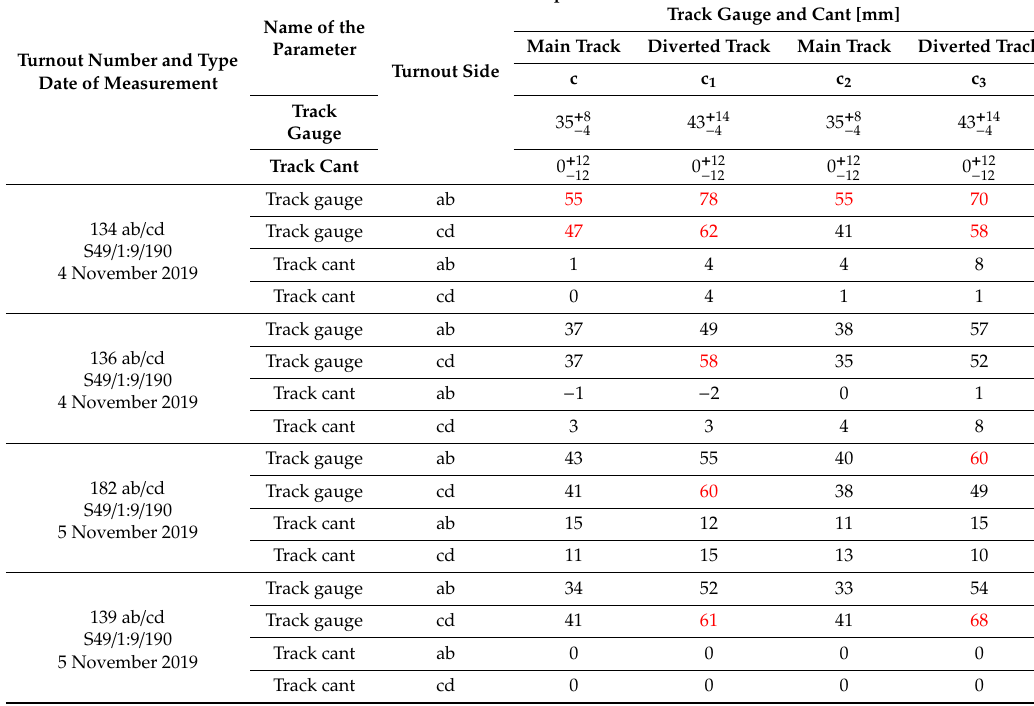
The red color indicates the exceeded